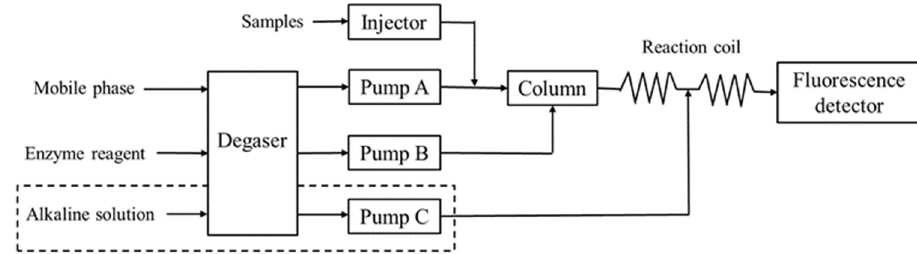
Figure 1. Schematic diagram of HPLC